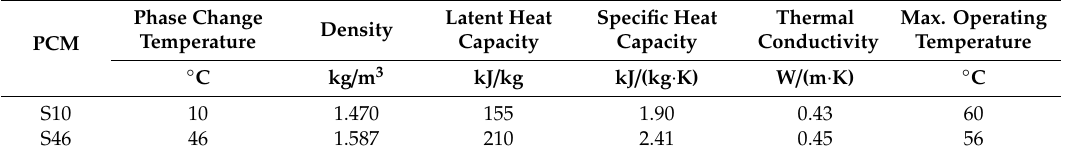
Table 1. Parameters of the selected phase change materials as provided by the supplier.